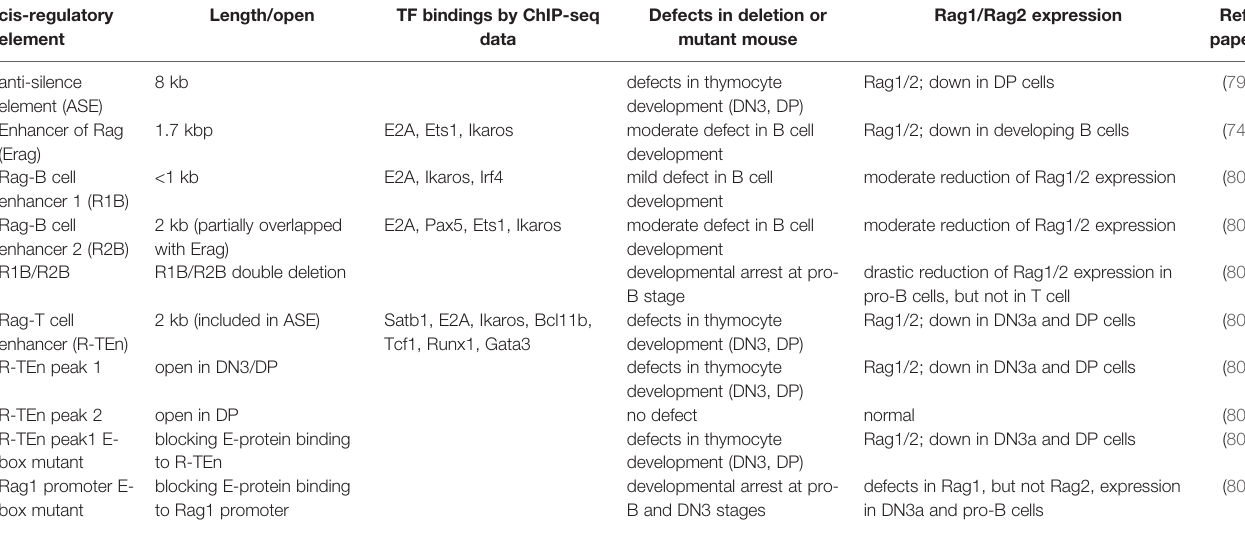
TABLE 1 | Description of Rag gene enhancer